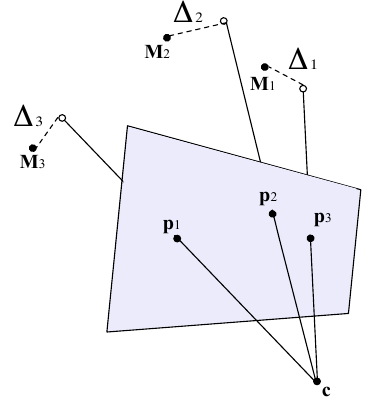
Figure 1: The orientation of the camera and the depth of the points are estimated in such a way to minimize the length of the ∆ s for all the points, in a least squares sense.